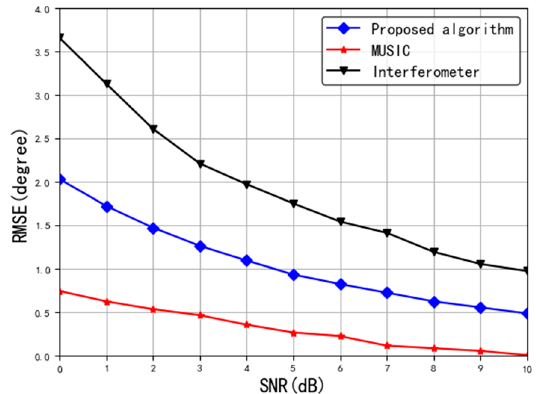
Figure 5. Relationship between estimation error and SNR.